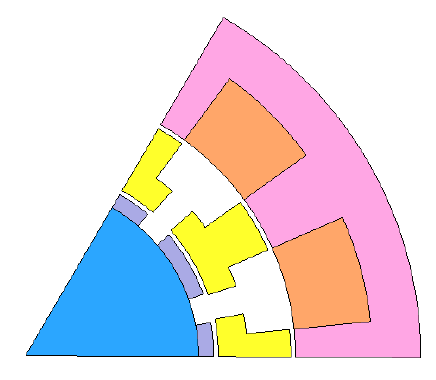
Figure 13. The 2D equivalent model.